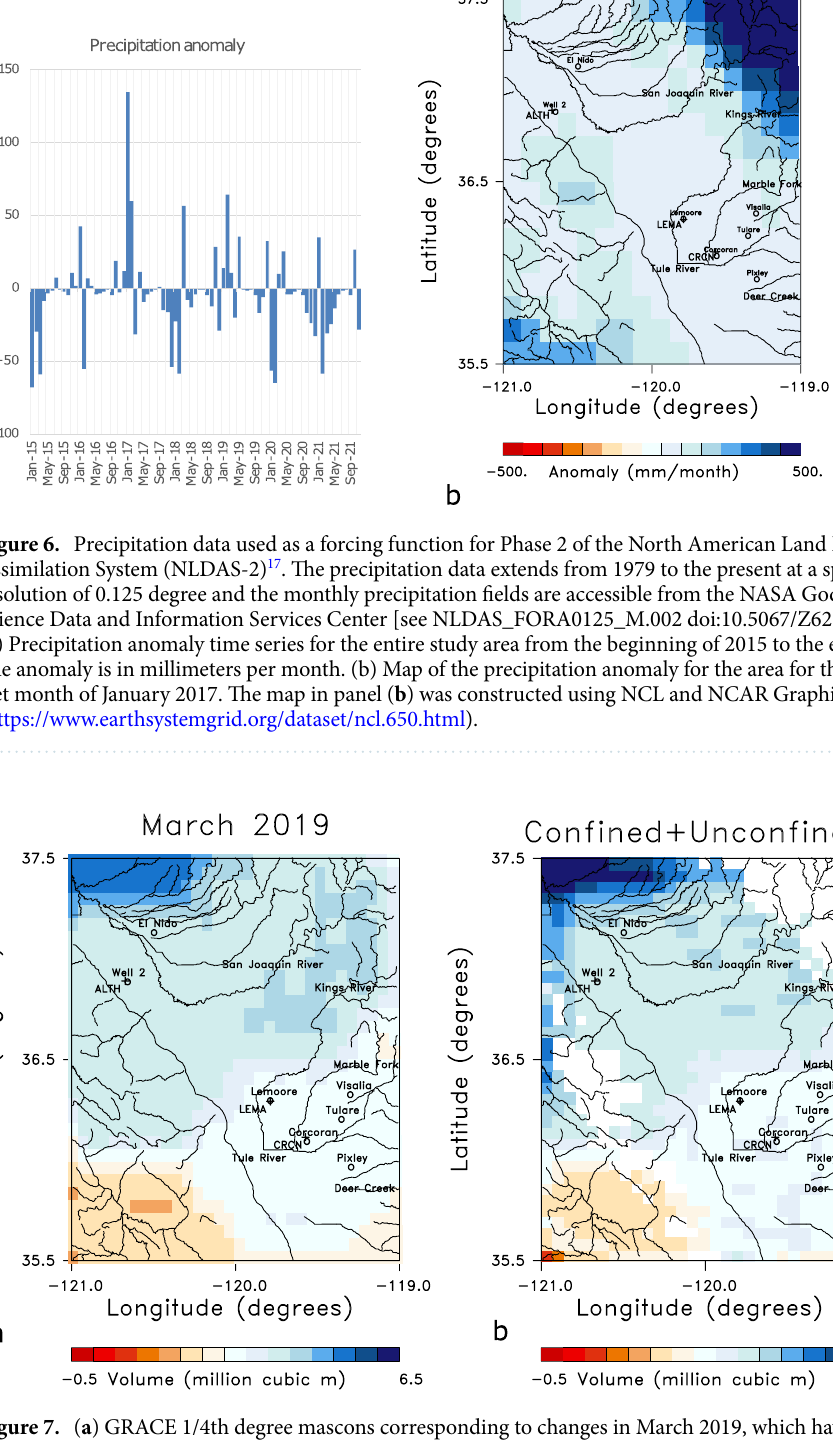
Figure 7. ( a ) GRACE 1/4th degree mascons corresponding to changes in March 2019, which have been sub-divided into 4x4 sub-grids and re-interpolated onto a finer grid that correlates with the Sentinel InSAR estimates. The color scale indicates the volume changes in millions of cubic meters during the month of March 2019. The water volume change has been reduced to reflect the smaller area (roughly 6km by 6km) that is represented in the finer grid. ( b ) The sum of the water volume changes in the unconfined and confined aquifers of the inversion result that is plotted in Fig. 8. The open circles denote towns in the area while the +’s indicate the locations of three GPS stations. The solid curves indicate rivers and streams in the region. The plots were constructed using NCL and NCAR Graphics 6.5.0 (https:// www. earth syste mgrid. org/ datas et/ ncl. 650.